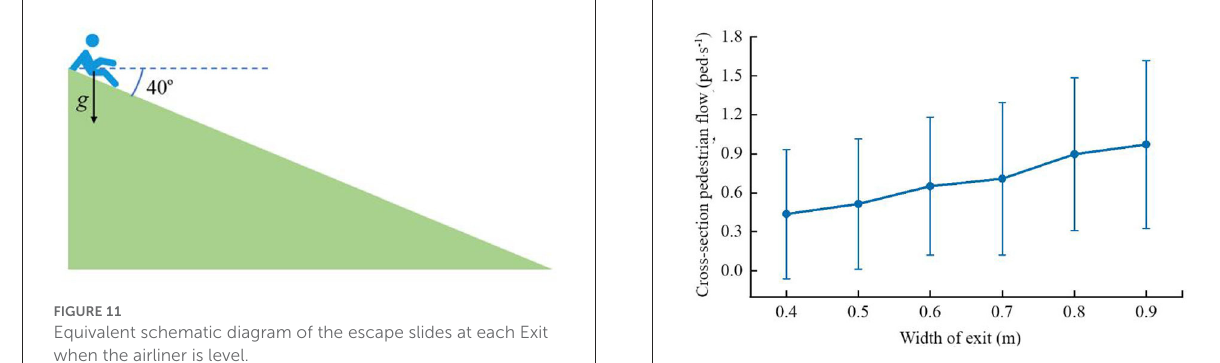
FIGURE12 Outlet section flow corresponding to different outlet widths (mean ± standard